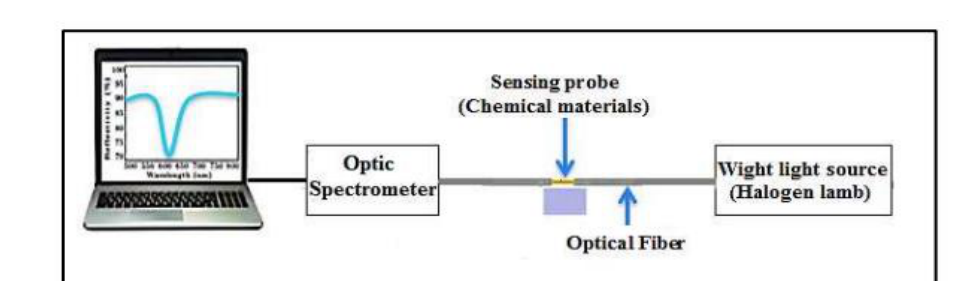
Figure 1: Experimental process.